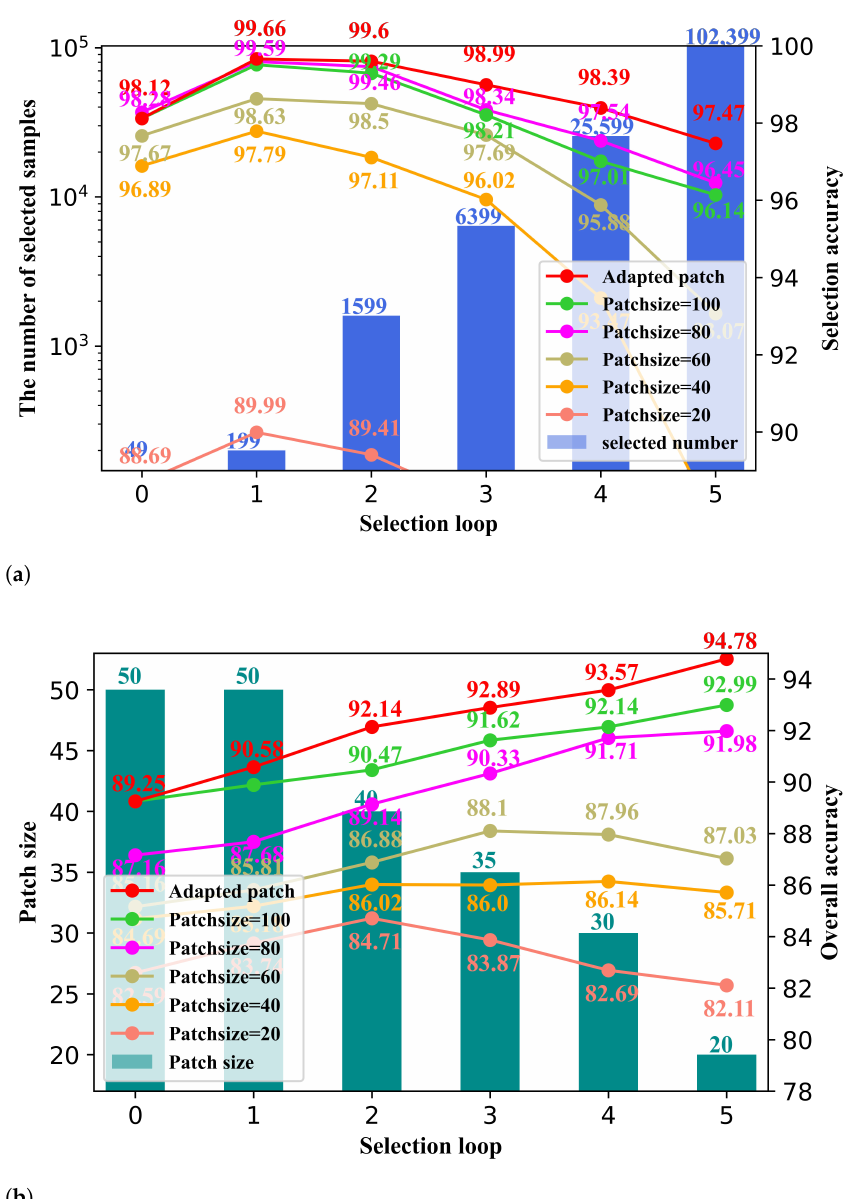
Figure 21. Ablation study on the effect of the patch size module. ( a ) The number of selected samples and selection accuracy for each selection loop; ( b ) The adaptive patch size in each selection loop and overall